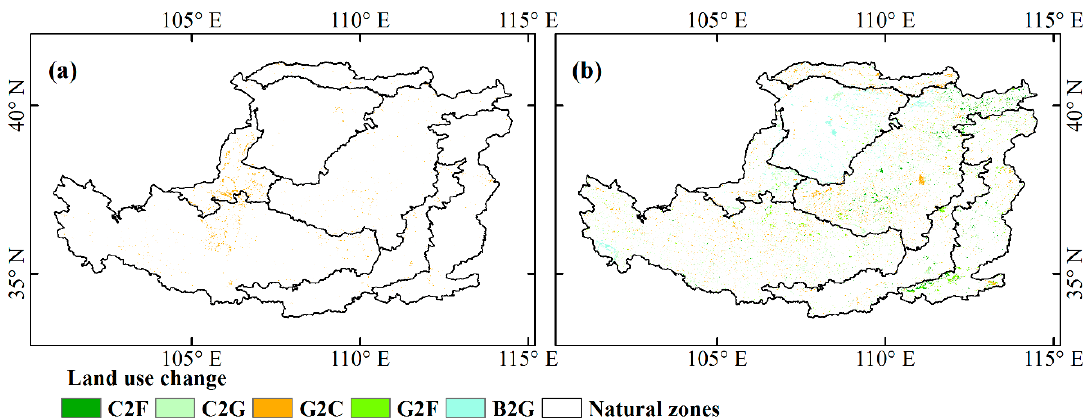
Figure 2. Major land use changes, with overall change area being greater than 0.5% of the entire study area during the periods 1990–1999 ( a ) and 2000–2010 ( b ). C2F represents conversion from croplands to forests; C2G represents conversion from croplands to grasslands; G2C represents conversion from grasslands to croplands; G2F represents conversion from grasslands to forests; and B2G represents conversion from barren or sparsely vegetated land to grasslands.